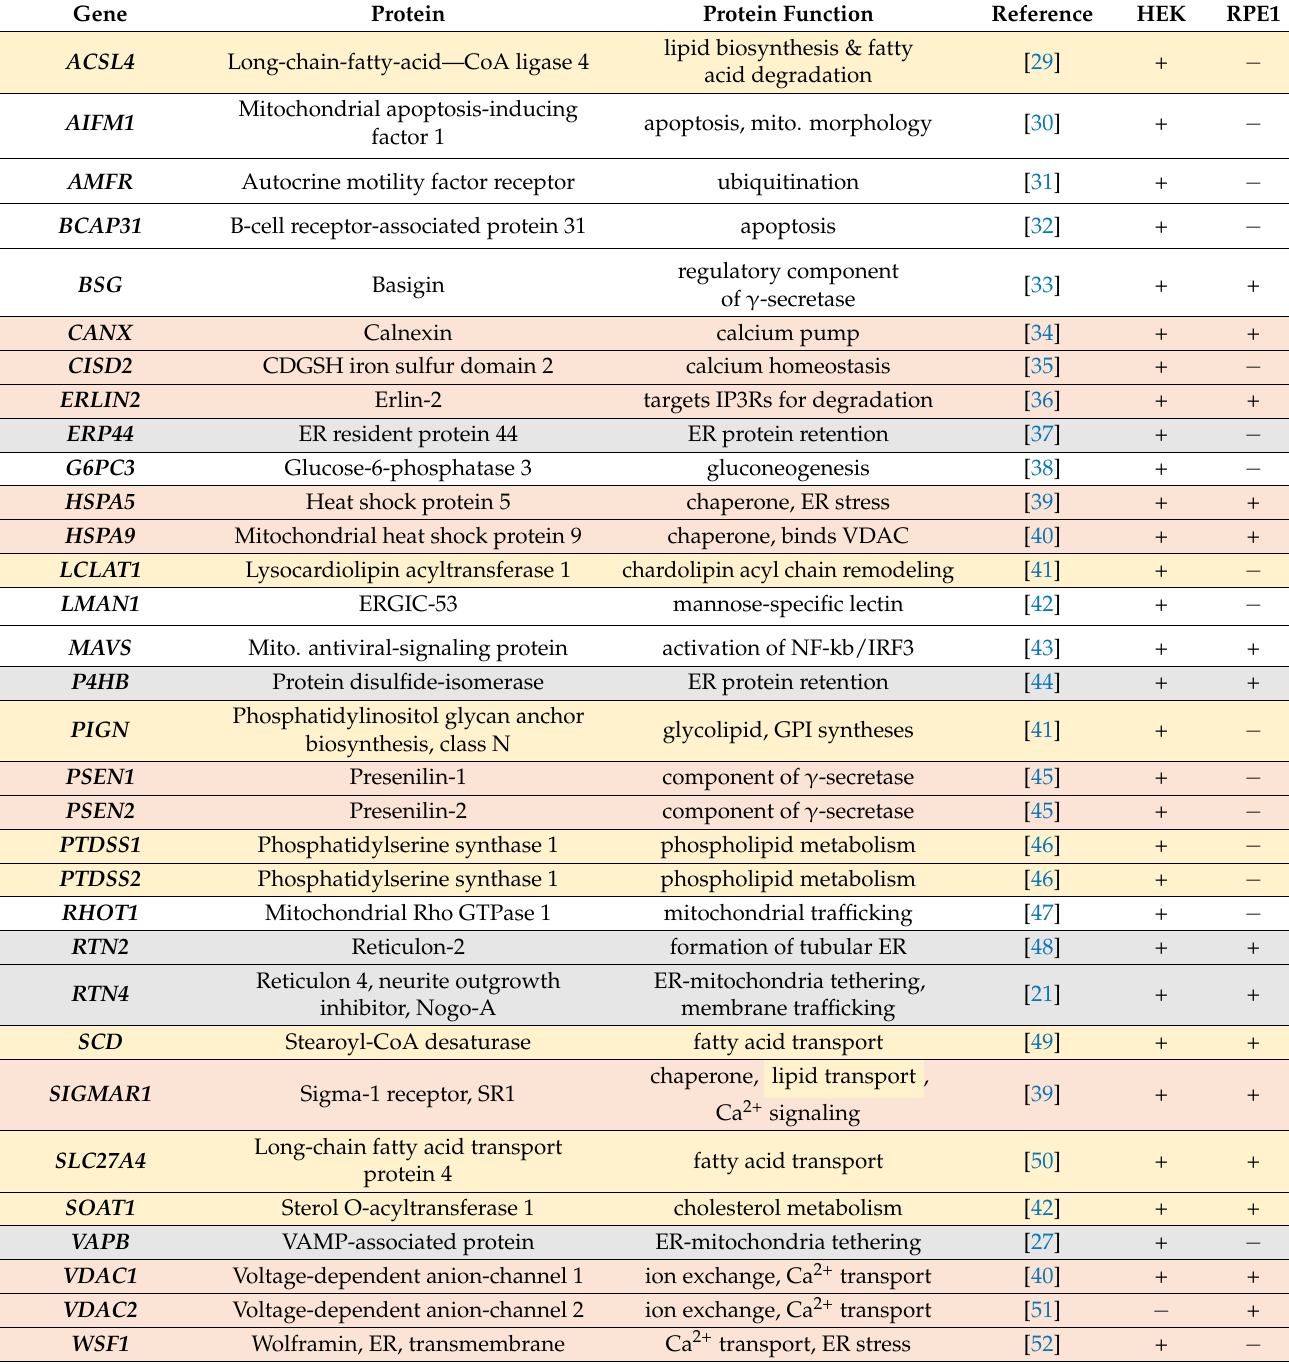
Table 1. MAM related proteins identified by VLGR1 TAPs in HEK293T and hTERT-RPE1 cells proteins associated with: Ca 2+ homeostasis, orange ; lipid metabolism, yellow , MAM structure, gray